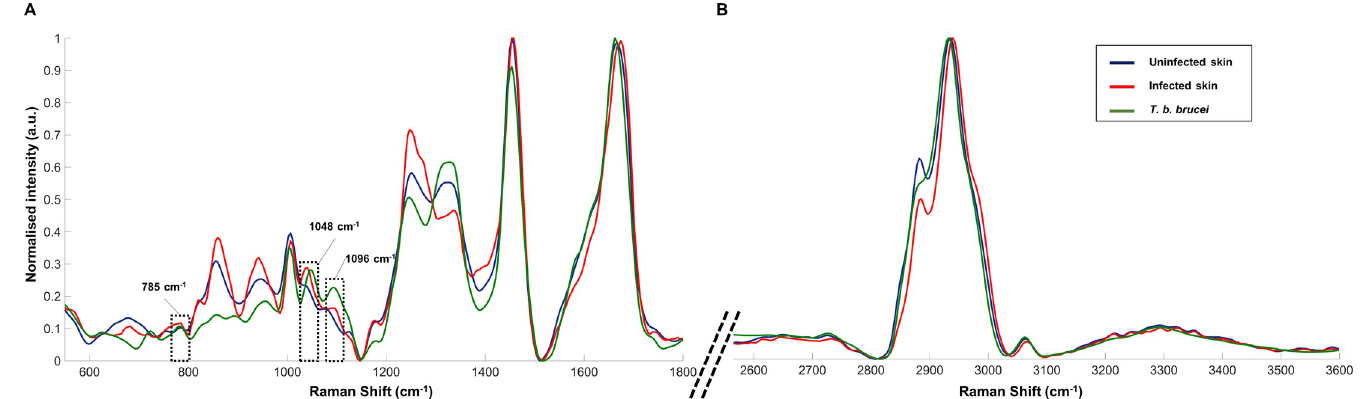
Fig 3. Spectral comparison between reference spectrum of T . b . brucei and uninfected and T . b . brucei murine infected skin (BALB/C). Five different T. b. brucei were mapped and averaged into a single Raman spectrum and both skin spectra were shown in Fig 2. Two Raman spectral region are shown: (A) 550–1800 cm -1 and (B) 2550–3600 cm -1